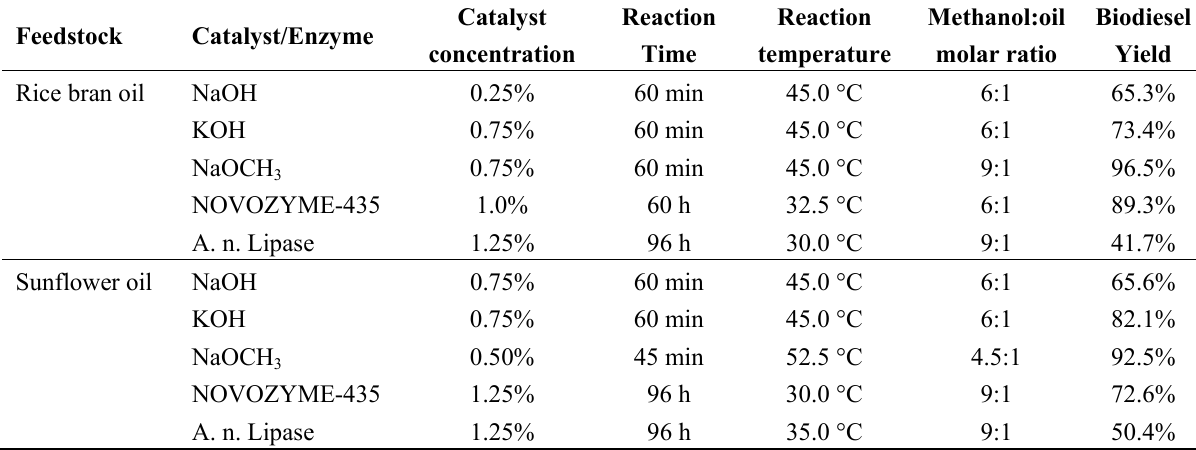
Table 7. Optimized reaction parameters for biodiesel production using chemical and enzymatic transesterification of understudy feedstock.